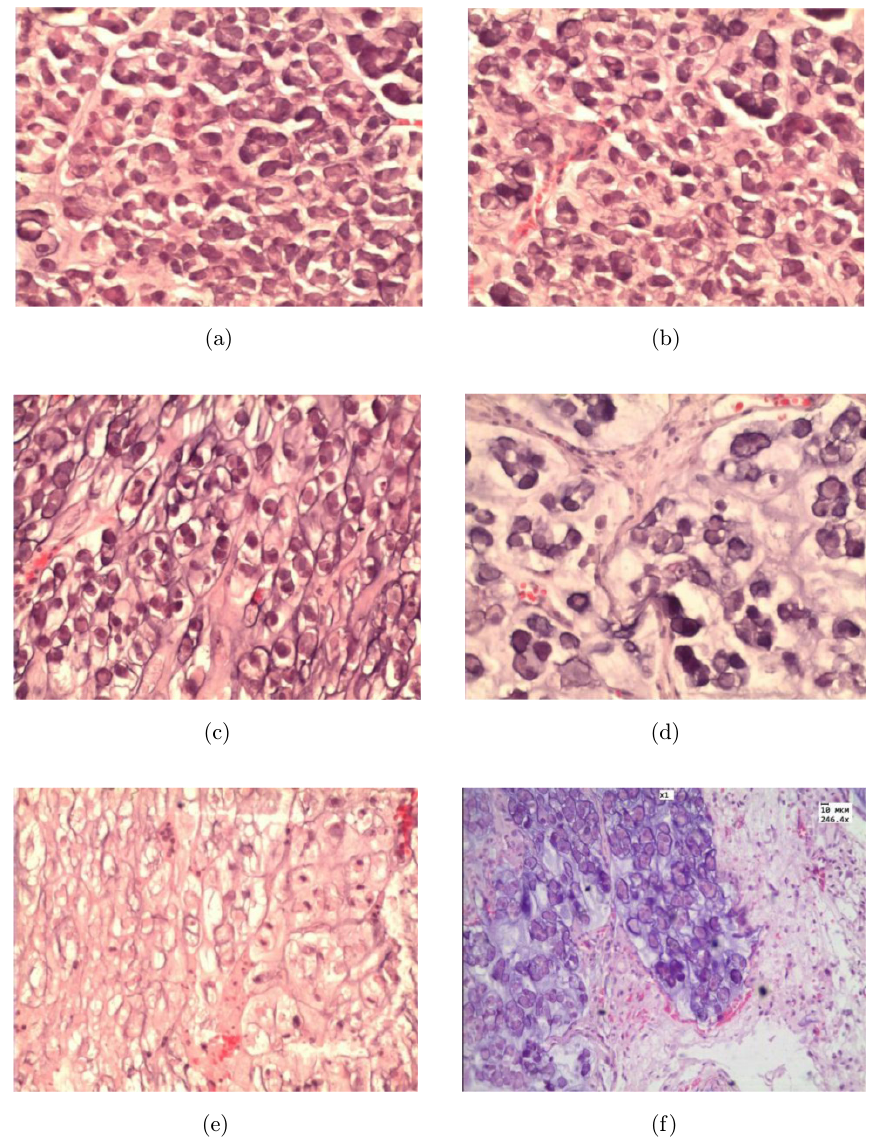
Fig. 5. Histological sections of a liver tumor: (a), (b) Comparison group (rats with PC-1). Tumor lobe with intact tumor cells. (c), (d) Group with laser hyperthermia. (c) Tumor lobe with degenerative changes of cells. (d) The leukocyte in¯ltration of the connective tissue septa, congestion of vessels. (e), (f) Group with PPTT. (e) Pronounced necrosis in tumor center. (f) The dystrophic changes in the tumor cells of subcapsular zone. Hematoxylin and eosin. ( (cid:3) 774).